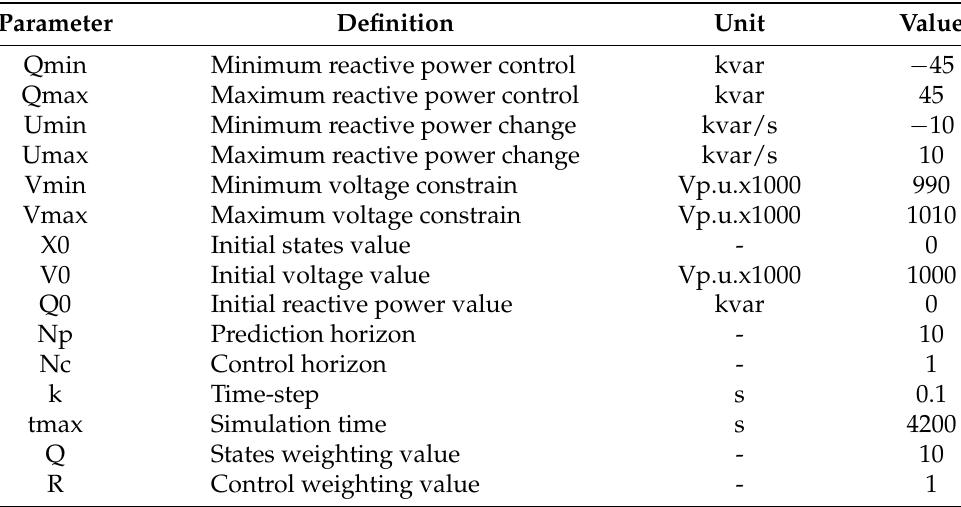
Figure 8. Weighting matrix Q and R tuning for the MPC controller. Table 3. Voltage controller simulation